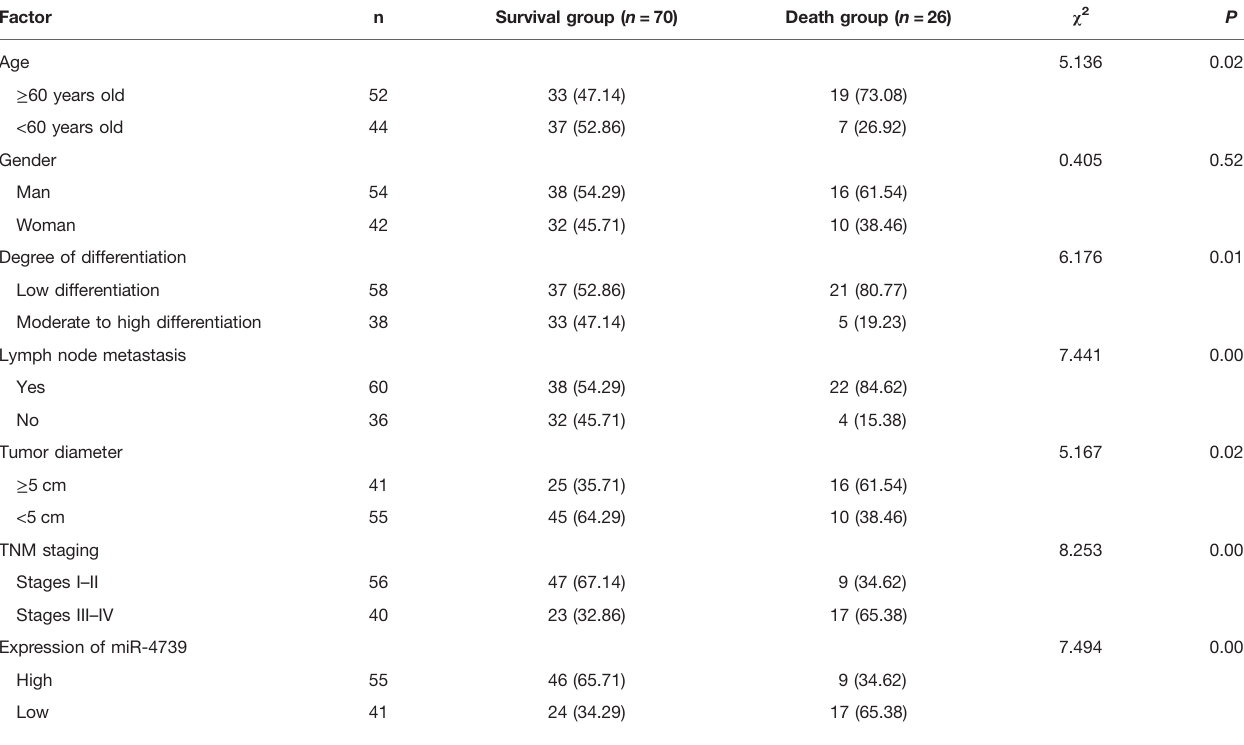
TABLE 3 | Univariate analysis of prognosis of patients with GC ( n ,%).